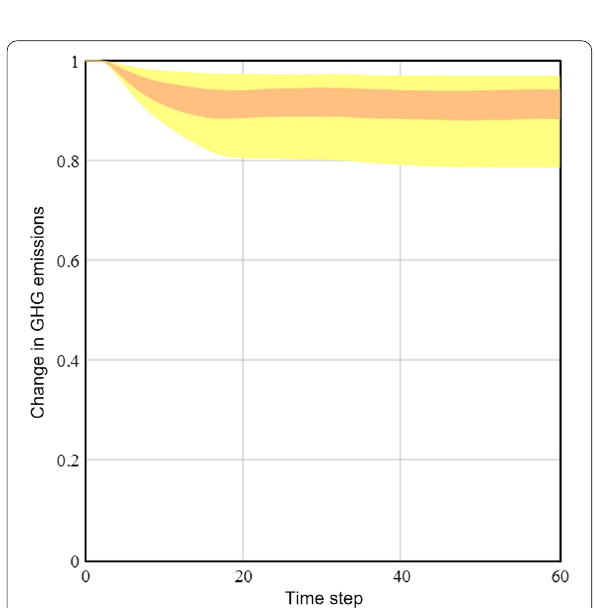
Fig. 7 Ease interventions for active and public transport travel under random sampling of all weights. Yellow: 100% range. Orange: 50% range